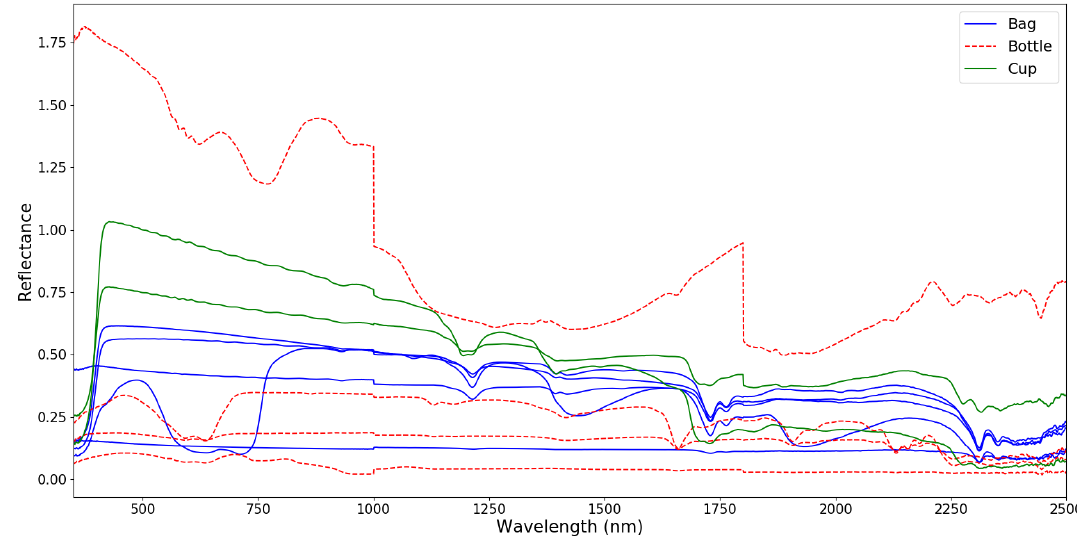
Figure 10. Spectral reflectance of bags and